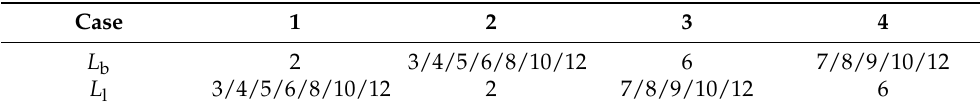
Table 3. Physical dimensions of strip widths of the mixed-wettability surfaces when the strip widths are different at θ l = 160 ◦ and θ b = 180 ◦ (nm).